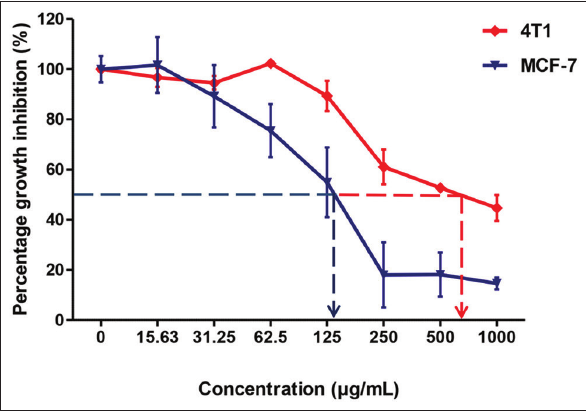
Figure-4: Minimum growth inhibitory concentration (IC